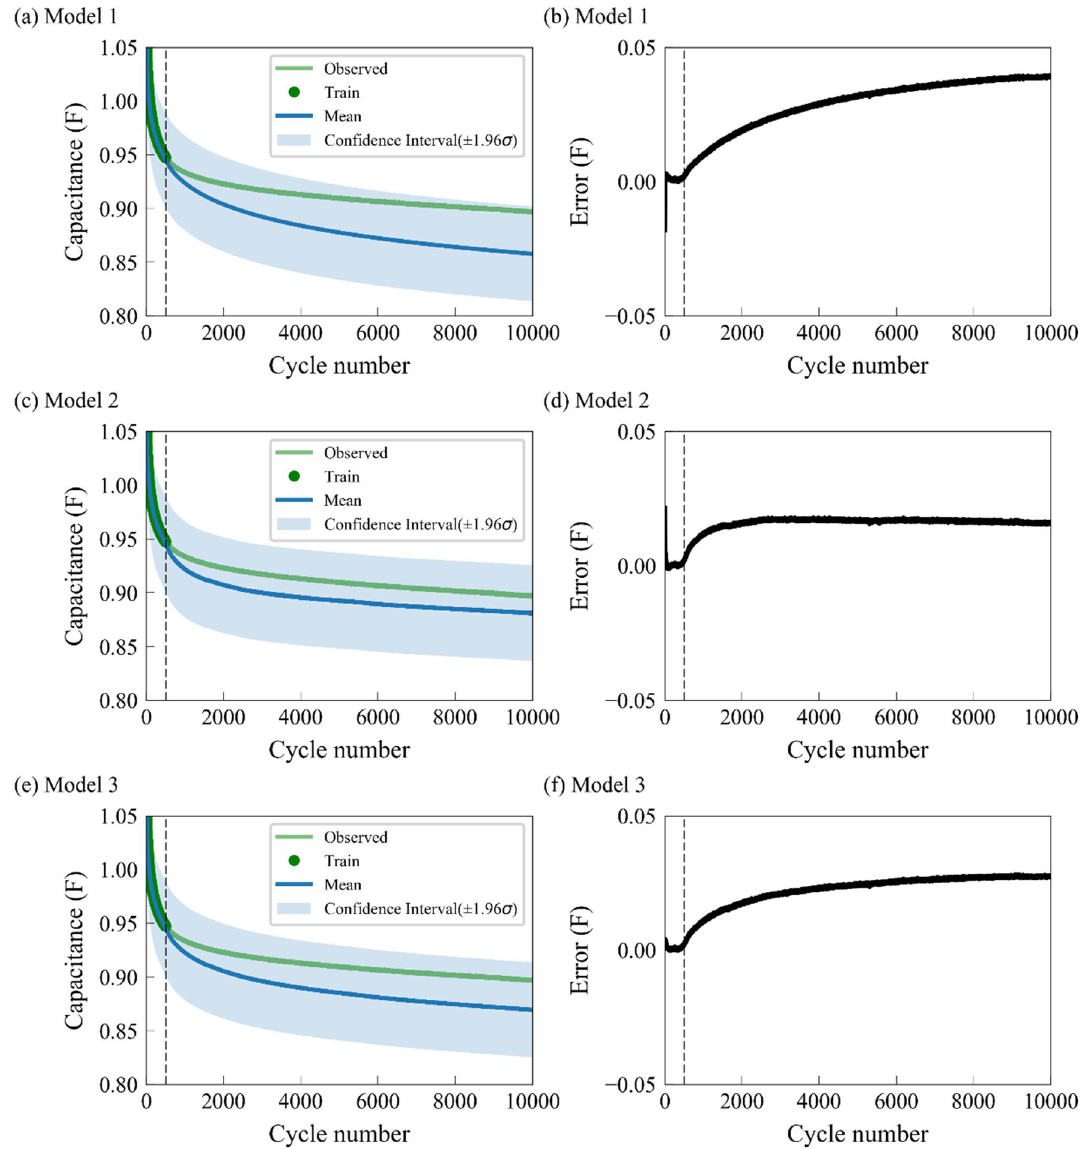
Figure 4. The capacitance predictions of three GPR models with different mean functions and covariance functions, where the first 5% cycles are used for training. ( a,c,e ) are the predicted capacitances of an SC for Models 1, 2, and 3, while ( b,d,f ) denote the predicted errors (observed − mean). The dotted line indicates the 500th cycle. The green and blue curves represent the observed and predicted mean capacitance, while the green dots, and blue shaded areas denote the predicted training data and confidence interval, respectively. The selection of ± 1.96 for confidence interval is based on Eq.